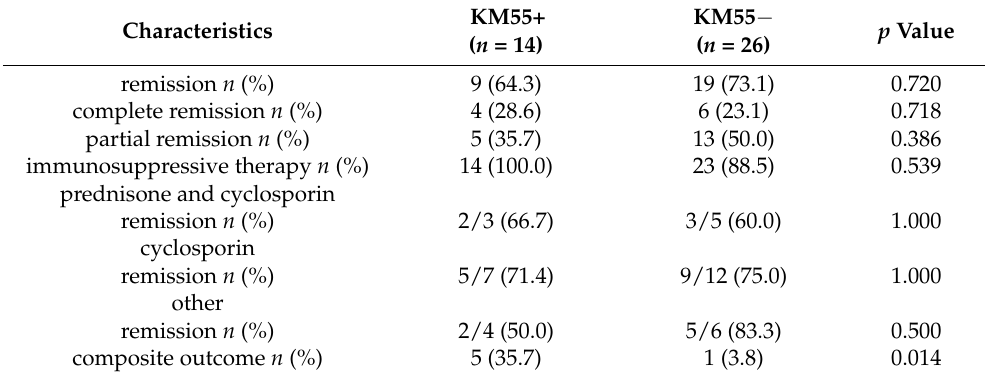
Table 7. Follow-up data in PMN/IgAN patients based on the staining of glomerular KM55.